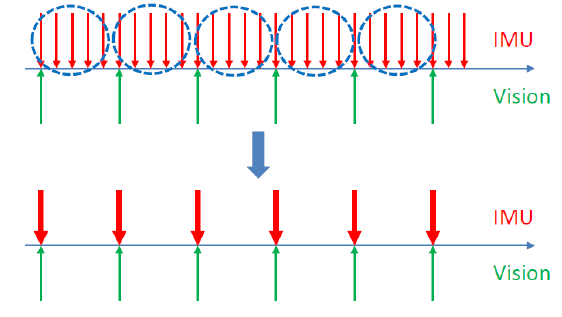
Figure 3. IMU Pre-integration